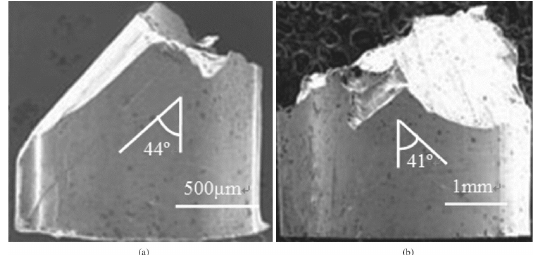
Table 1. The materials constant used for ABAQUS program.